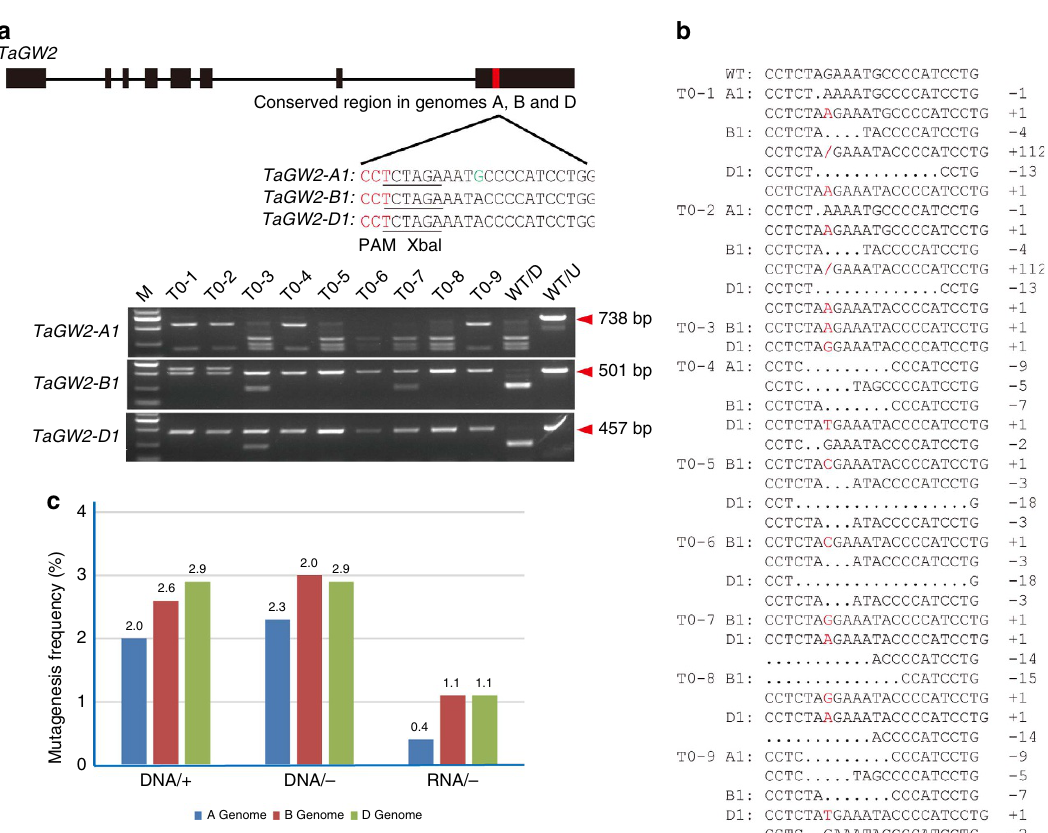
Figure 3 | Development and testing of TECCRNA method. ( a ) Sites within a conserved region of exon 8 of wheat TaGW2 homoeologues targeted by CRISPR/Cas9 systems. The PAM sequence is highlighted in red, the XbaI restriction sites are underlined and the single-nucleotide polymorphism in the targeted sequences is highlighted in green. Outcome of PCR-RE assays analysing nine representative tagw2 mutants is shown. Lanes T0-1 to T0-9 show blots of PCR fragments amplified from independent wheat plants digested with XbaI. Lanes labelled WT/D and WT/U are PCR fragments amplified from WT plants with and without XbaI digestion, respectively. The bands marked by red arrowheads are caused by CRISPR/Cas9-induced mutations. ( b ) CRISPR/Cas9-induced mutant TaGW2 alleles identified by sequencing. ( c ) Comparison the mutagenesis frequencies for three homoeologues of TaGW2 of three genome-editing